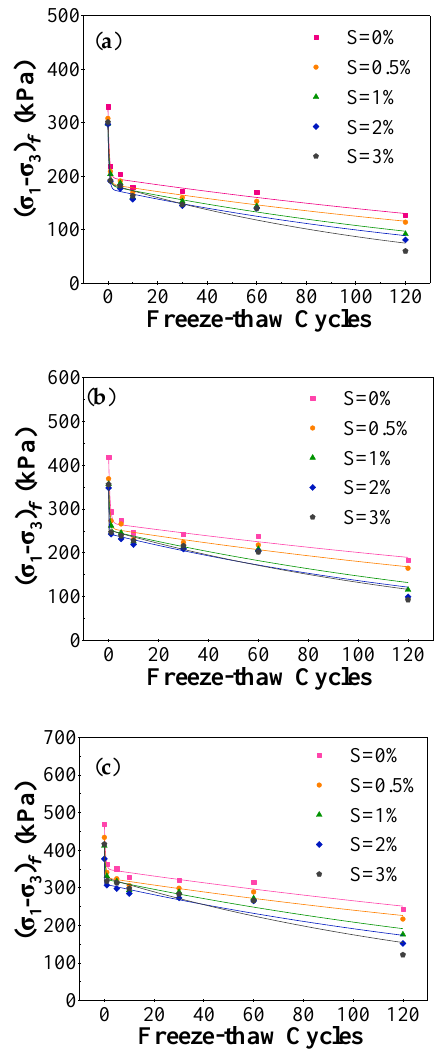
Figure 2. Variation of failure principal‐stress difference (σ 1 − σ 3 ) f with FTC: ( a ) σ 3 = 100 kPa; ( b ) σ 3 = 200 kPa; ( c ) σ 3 = 300 kPa.